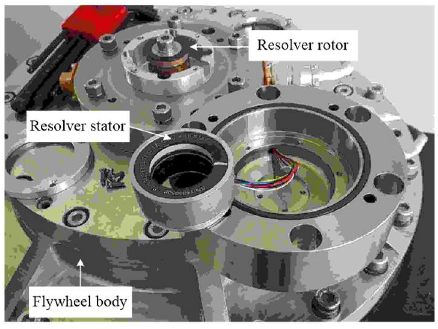
Figure 6. Resolver in the